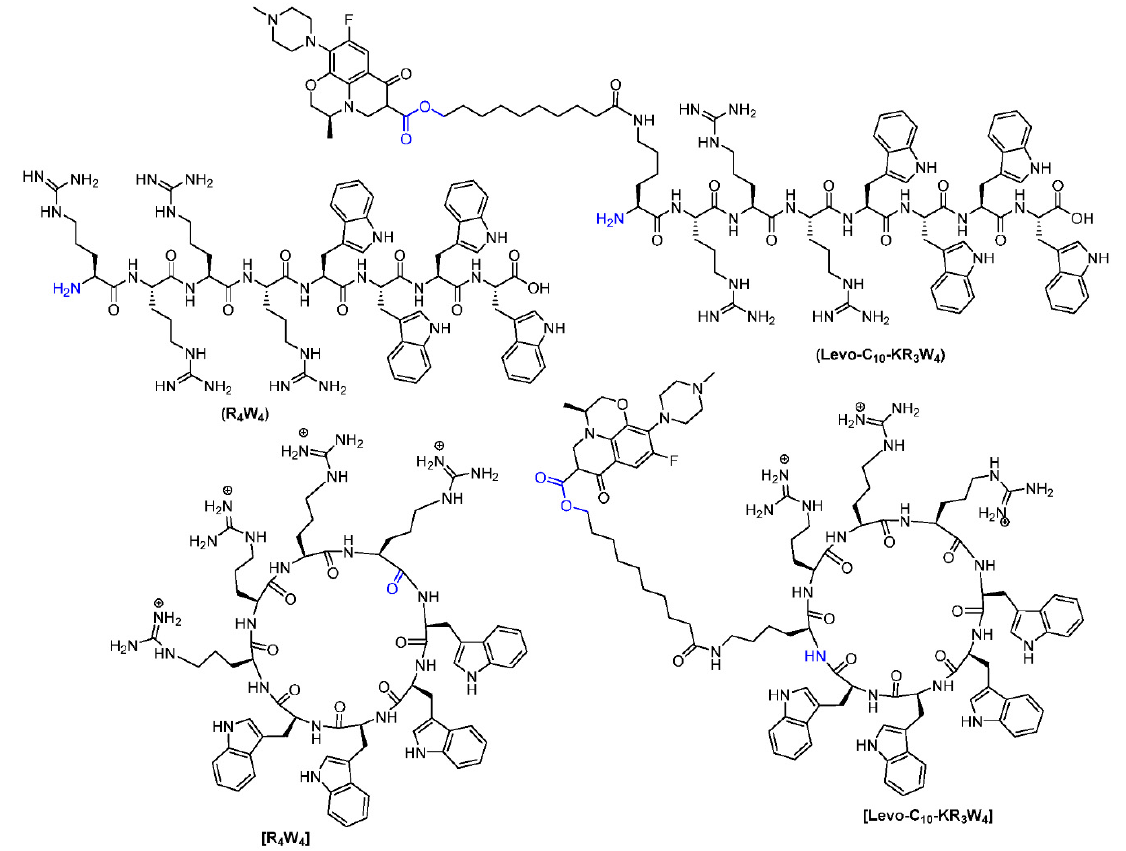
Figure 1. Chemical structures of synthesized peptides and conjugates.